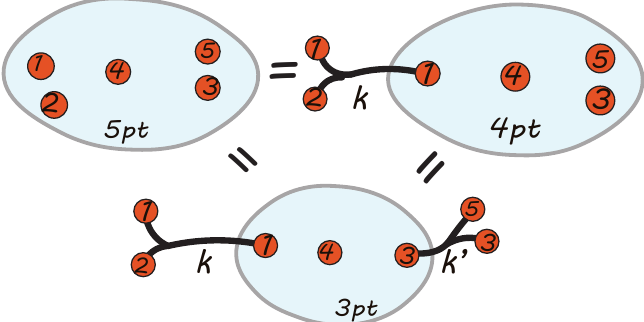
Figure 9. A (cid:12)ve-point function can be written in terms of sum of four-point function where one of the operators appears in the OPE of (12) or in terms of a sum of three-point function where now one of the operator appears in OPE of (12) and the other in the OPE of